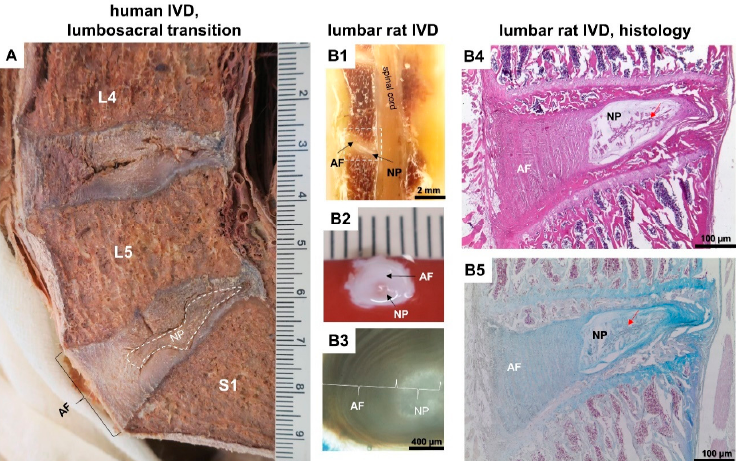
Figure 1. Lumbar intervertebral discs (IVD) of humans and rats. ( A ): degenerated human lumbar IVD - it is Thompson grade 4 or Ray grade 2 since fissures are detectable, extending from NP through